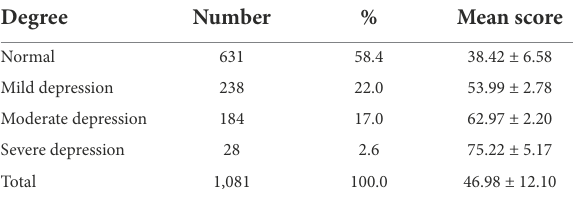
TABLE 1 The distribution of different levels of